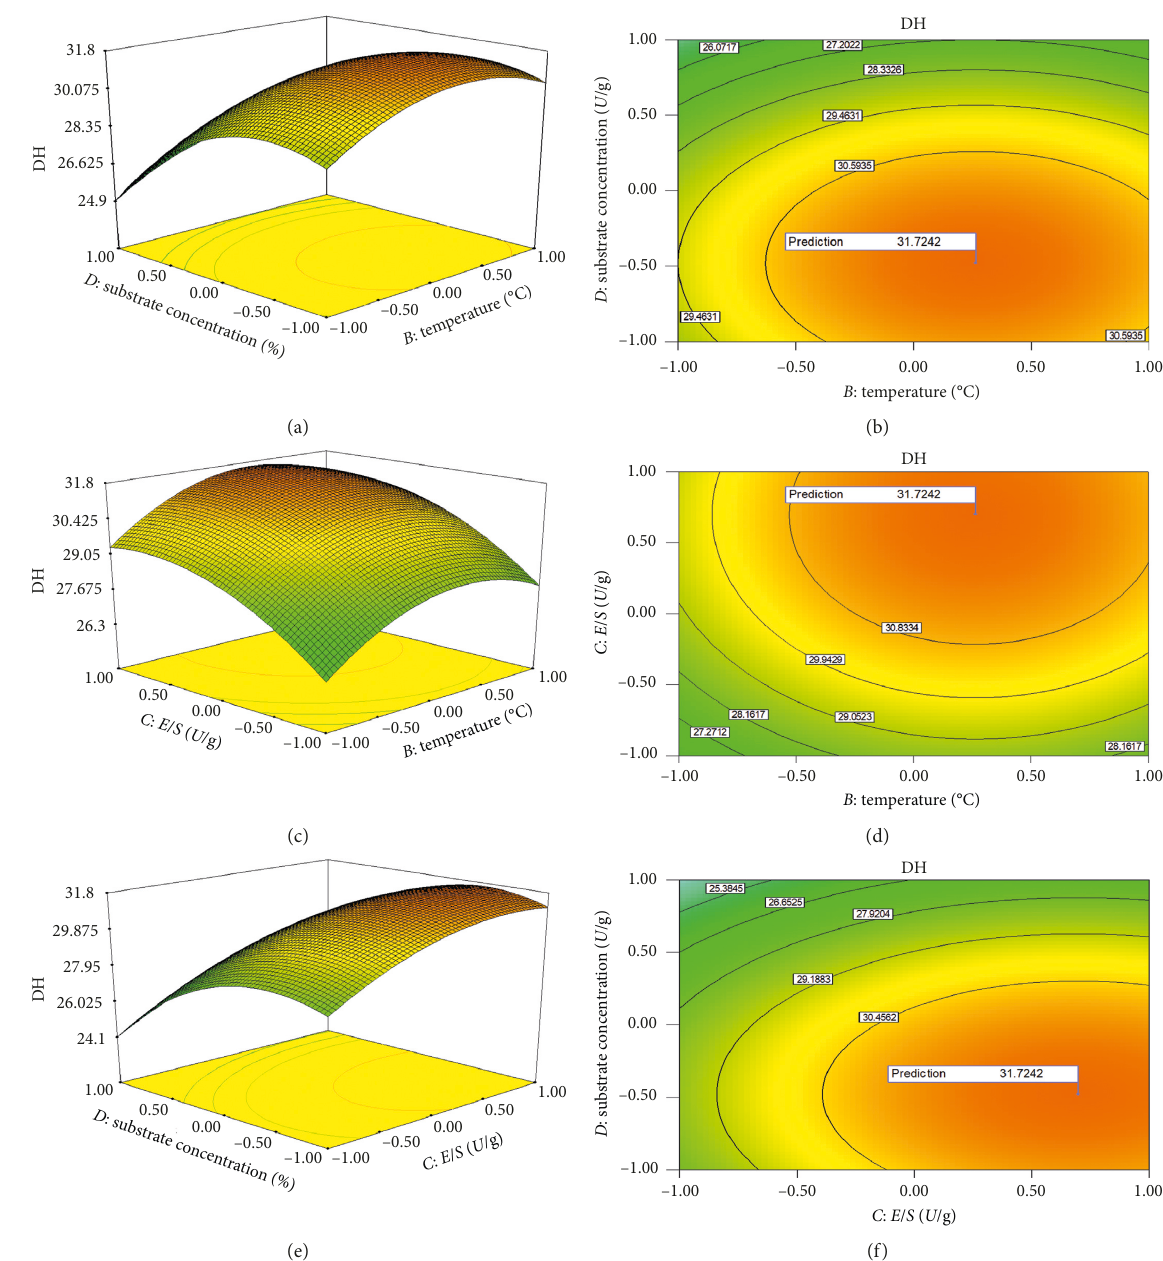
Figure 3: Response surface three-dimensional map and contour plots of the degree of